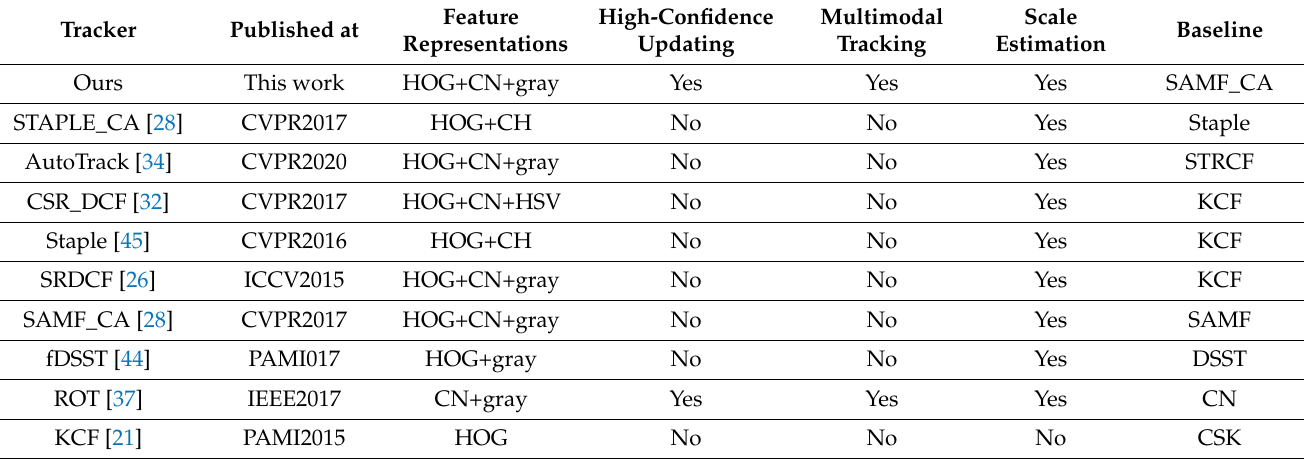
Feature High-Confidence Multimodal Scale Representations Updating Tracking Estimation